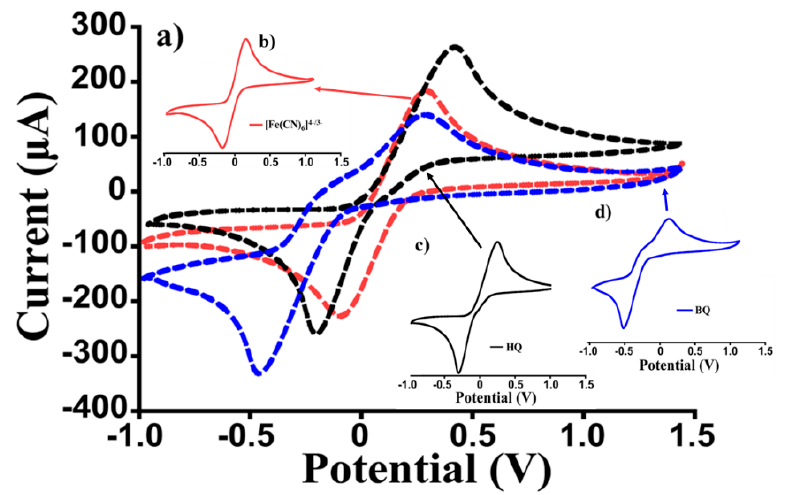
Figure 5. Comparison of the cyclic voltammograms; (a) simultaneous determination of the 3 ana- lytes; (b–d) PF, HQ, and BQ were analyzed separately.